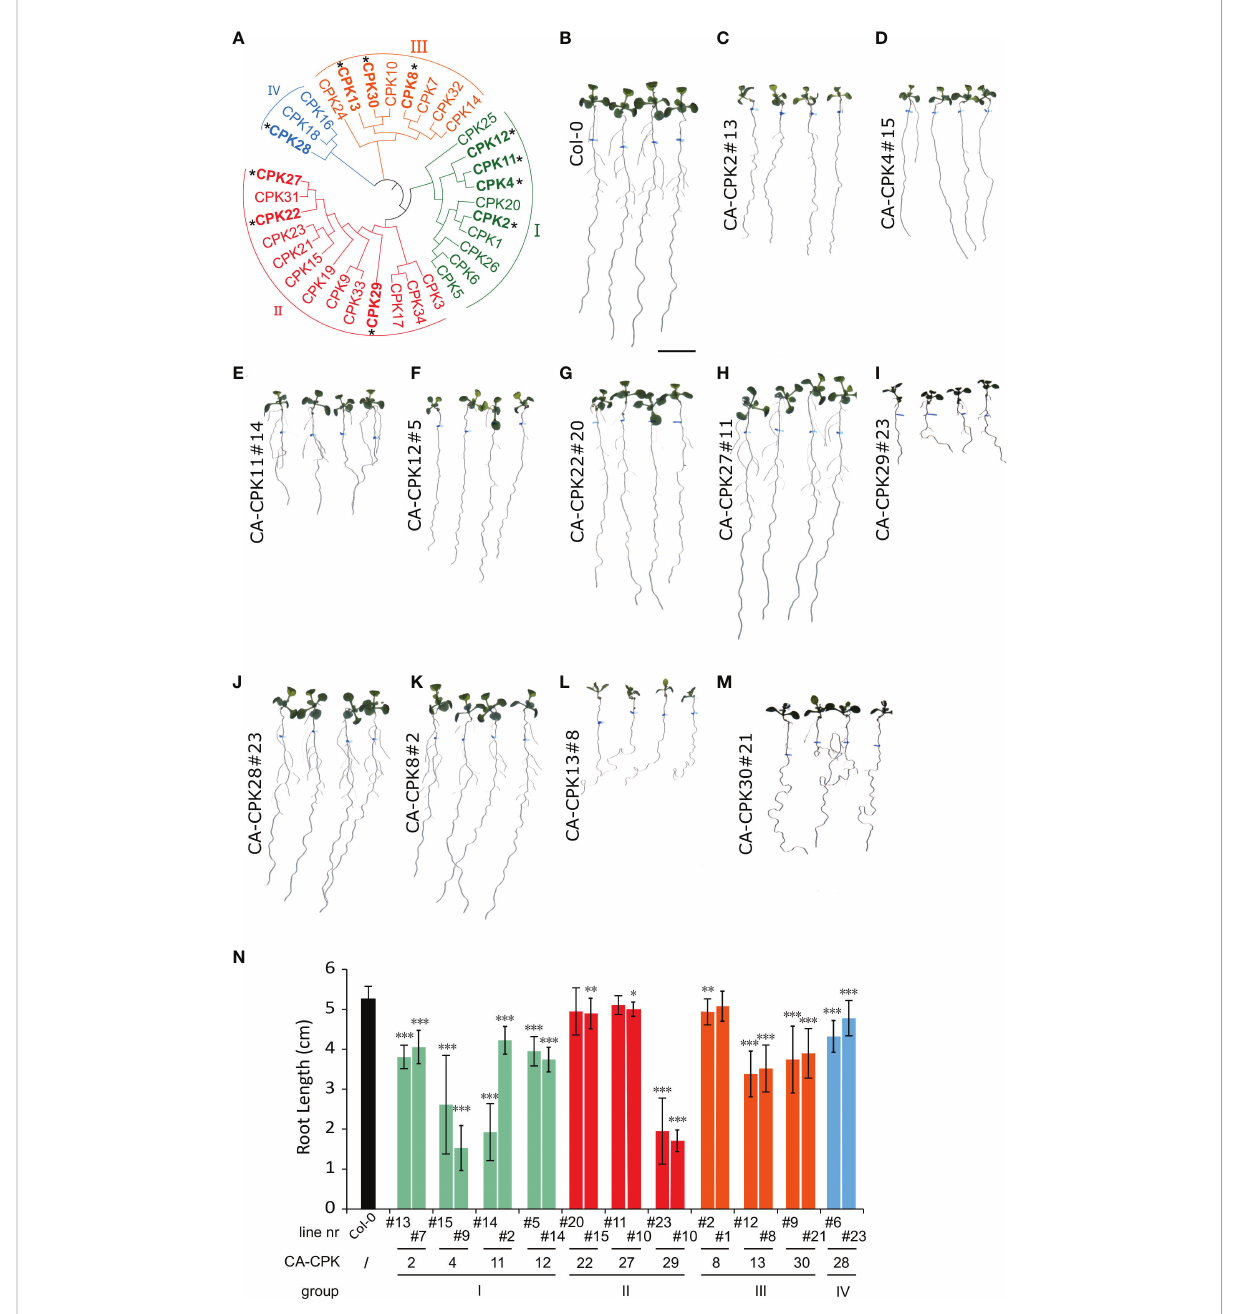
FIGURE 1 Phenotypic screen of constitutive active CPKs. (A) Phylogenetic tree of the Arabidopsis CPK family, with indication of the four main subgroups (I-IV).CPKs indicated with an asterisk were analyzed via stable overexpression lines. (B – M) Overview of macroscopic phenotypes of CA-CPK lines relative to WT (Col-0).Seeds were grown for 5 days on 1/2 × MS medium then transferred to medium supplemented with 2.5 m M b - estradiol for another 7 days. Scale bar = 1 cm. (N) Quanti fi cation of root length for indicated CA-CPK lines. Data are represented as the mean ± SD of at two independent replications. n ≥ 12 for all lines, except for CPK12#14 (n = 6) and CA-CPK22#20 ( n = 7). Asterisk indicates signi fi cant difference (Unpaired Student ’ s t -test; * P ≤ 0.05, ** P ≤ 0.01, *** P ≤ 0.001) between transgenic lines and WT (Col-0)